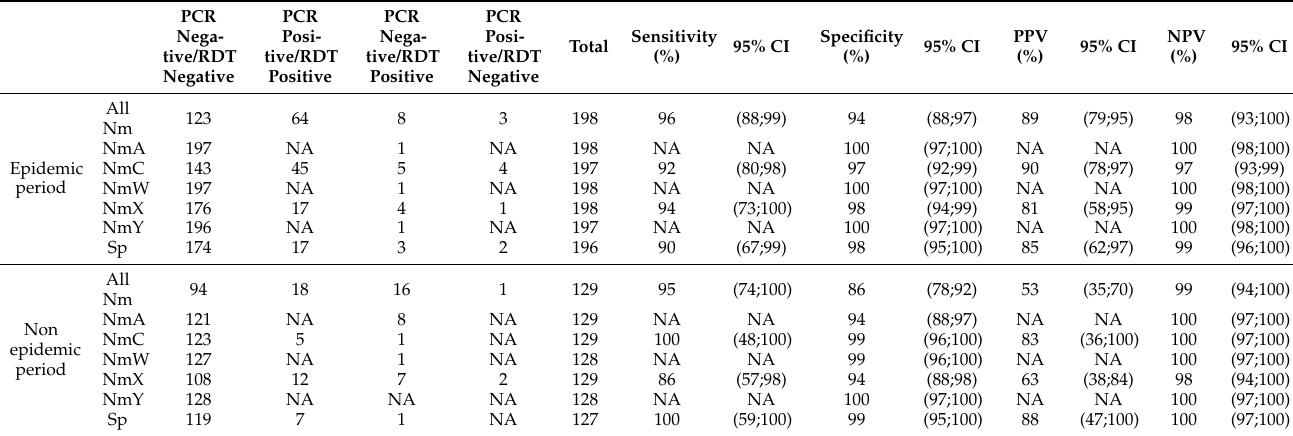
Table 4. Concordance of results obtained by RDT in PHCs with results obtained by PCR in NRLs, and serogroup specific performances, by epidemic vs. non epidemic period, Burkina Faso and Niger, 2018–2019.